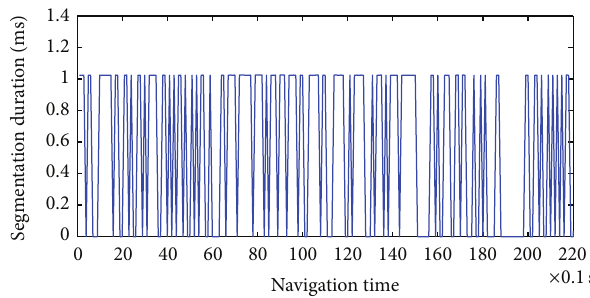
Figure 11: Segmentation duration using height histogram method.